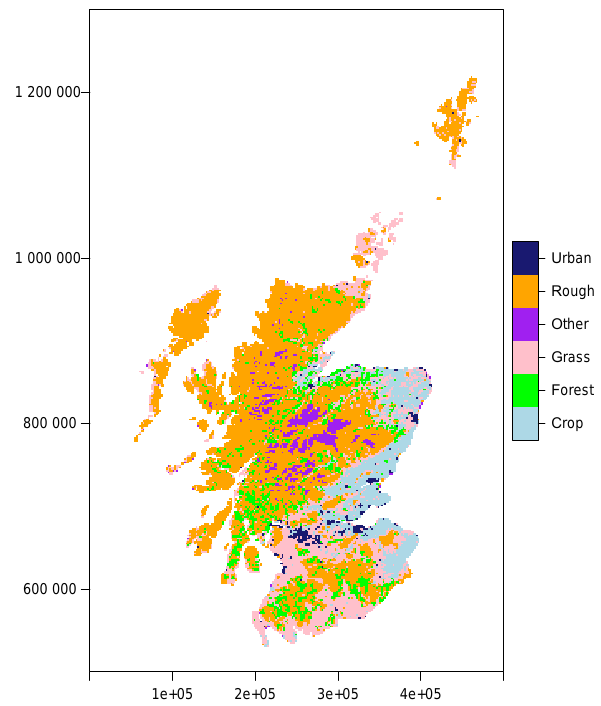
Figure 3. Land use in Scotland in 2015 as estimated by the CEH Land Cover Map. “Grass” comprises all improved and actively managed agricultural grassland. “Rough” includes all rough graz- ing, unmanaged grassland and semi-natural land. “Other” com- prises barren areas such as montane and coastal areas. Map coor- dinates are in British National Grid. For legibility, we show data aggregated to 2km squares, though they are available at 25m reso-